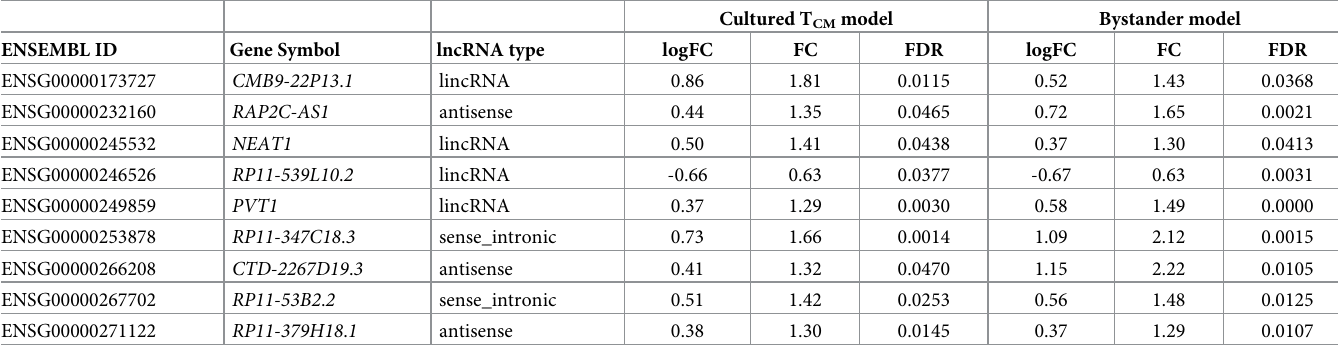
Table 2. LncRNAs dysregulated in common between the cultured T CM and the bystander